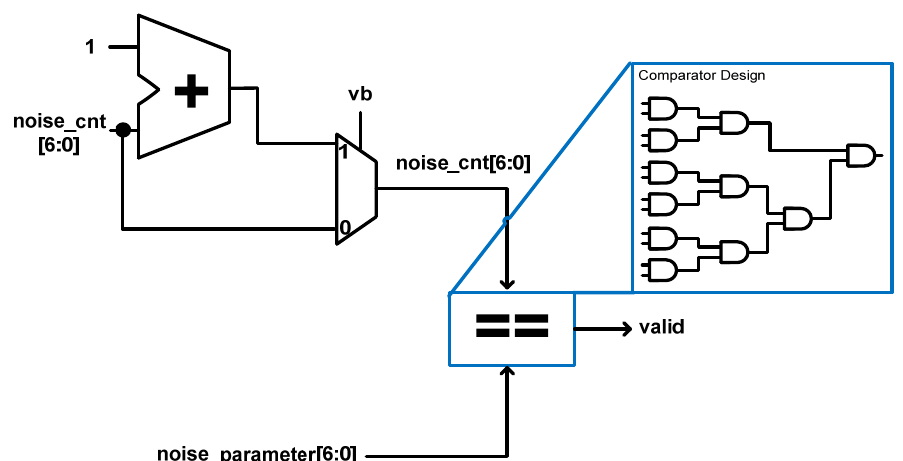
Figure 12. Proposed architecture for VERIFICATION unit.